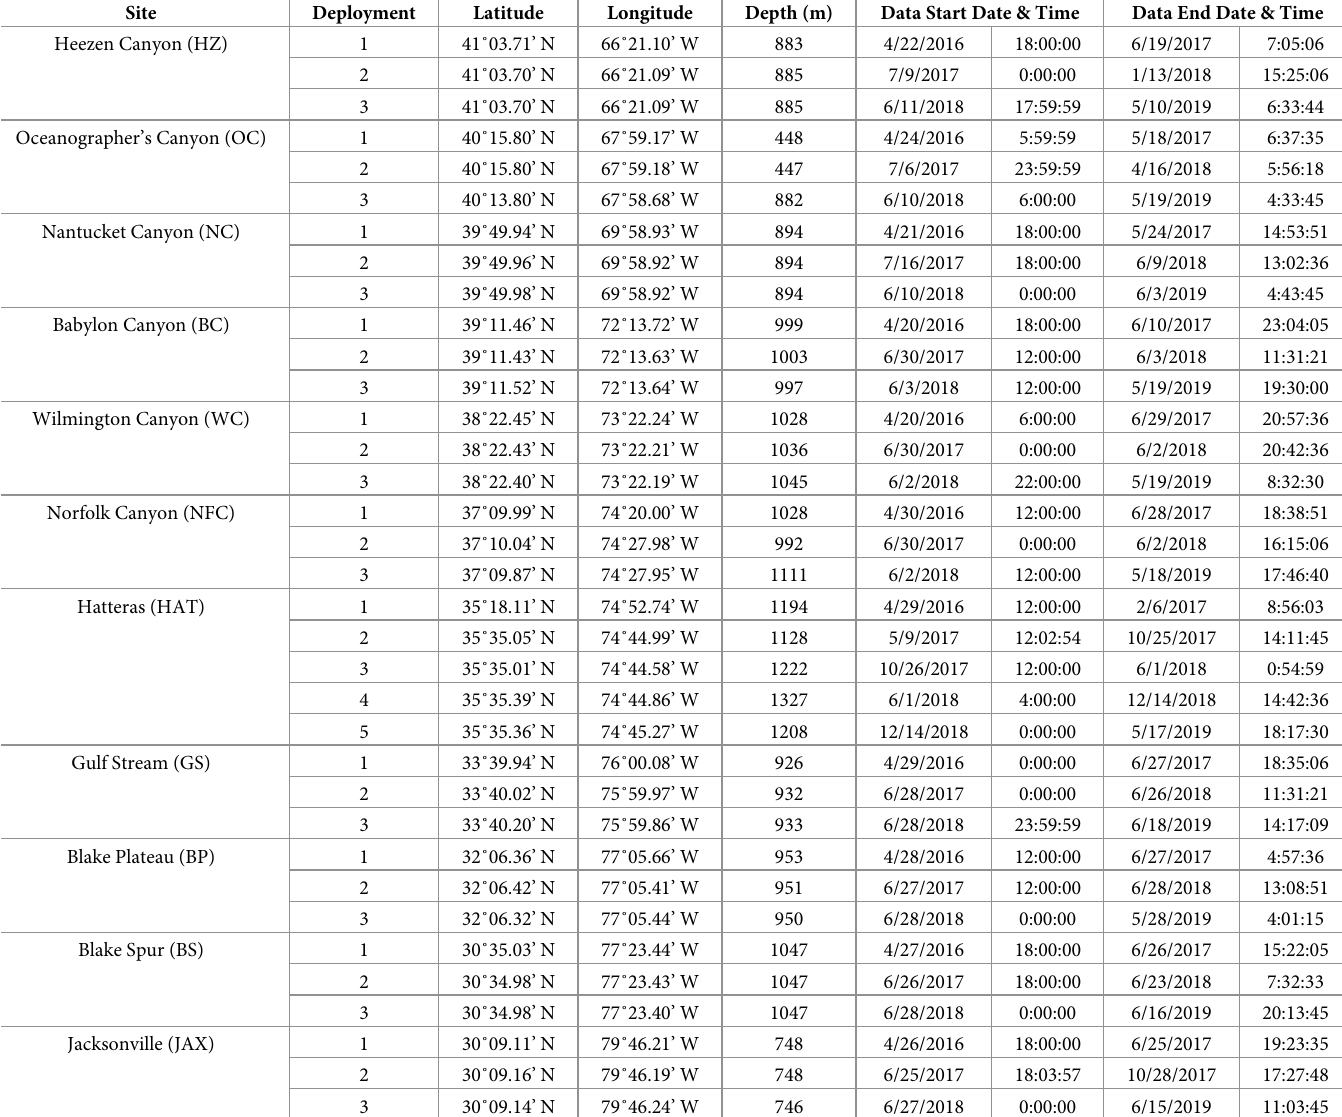
Table 1. HARP deployment information for repeated deployments at the acoustic monitoring sites shown in Fig 1.